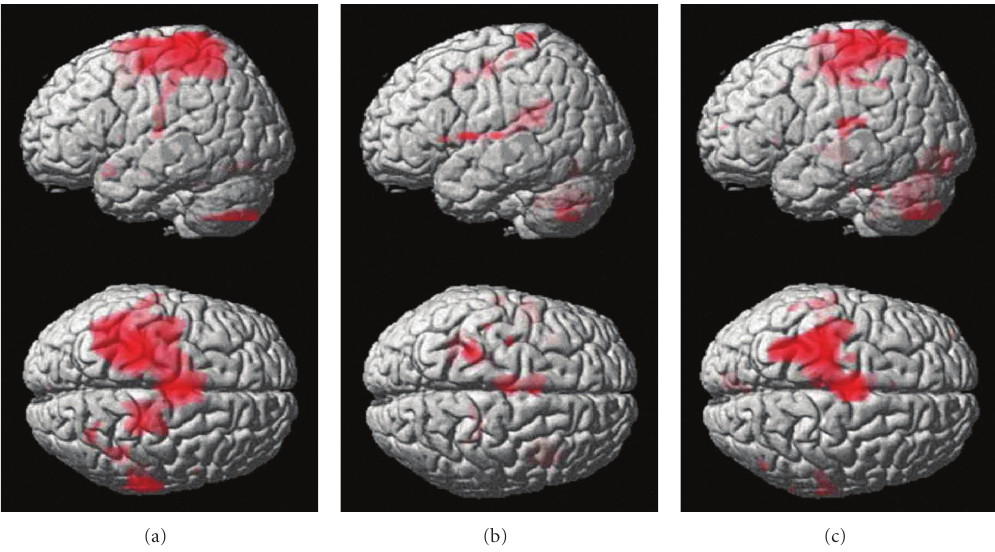
Figure 3: A rendering of analysis results using the fixed-e ff ect model of seven BPI patients during the motor task of the a ff ected elbow. (a) the first fMRI (before operation), (b) the second fMRI (approximately 1 year after operation), and (c) the third fMRI (approximately 2 years after operation).